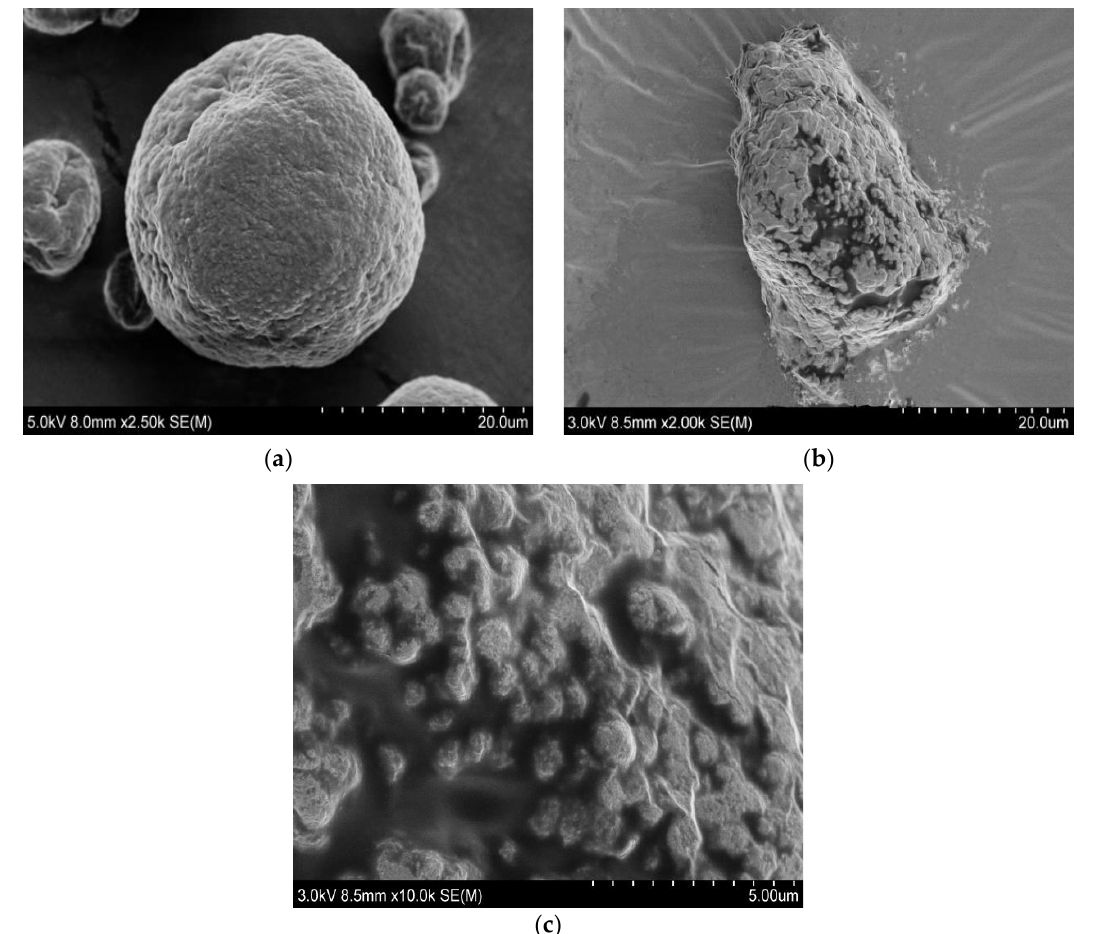
Figure 7. SEM images of BX and GMA BX-PA. ( a ) SEM image of BX. ( b ) SEM image of GMA BX-PA ( c ) SEM surface image of GMA BX-PA.